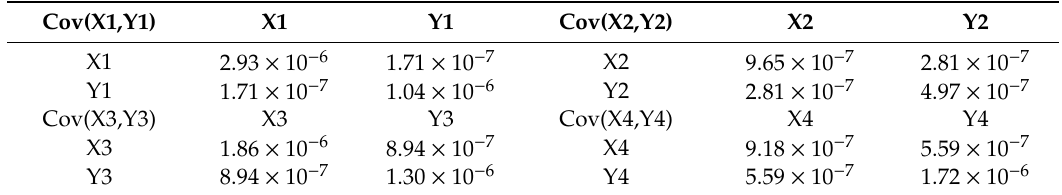
Figure 6. Four vertex coordinates in the Gaussian plane coordinate system. Figure 6. Coordinate error of four vertices (38 data( a ), 30 data( b ), 29 data( c ) and 23 data( d )). Table 1. Covariance between abscissa and ordinates of the Gaussian plane coordinate system.